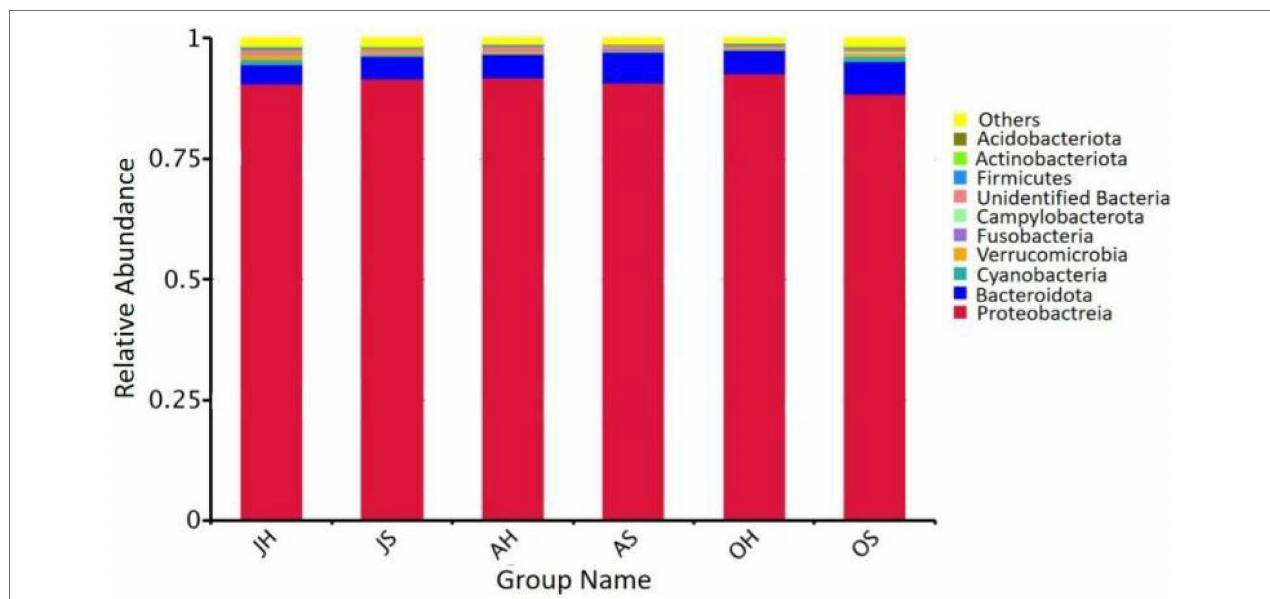
FIGURE 3 | Relative abundance of epiphytic bacteria at the phylum in M. spicatum from Baiyangdian Lake.